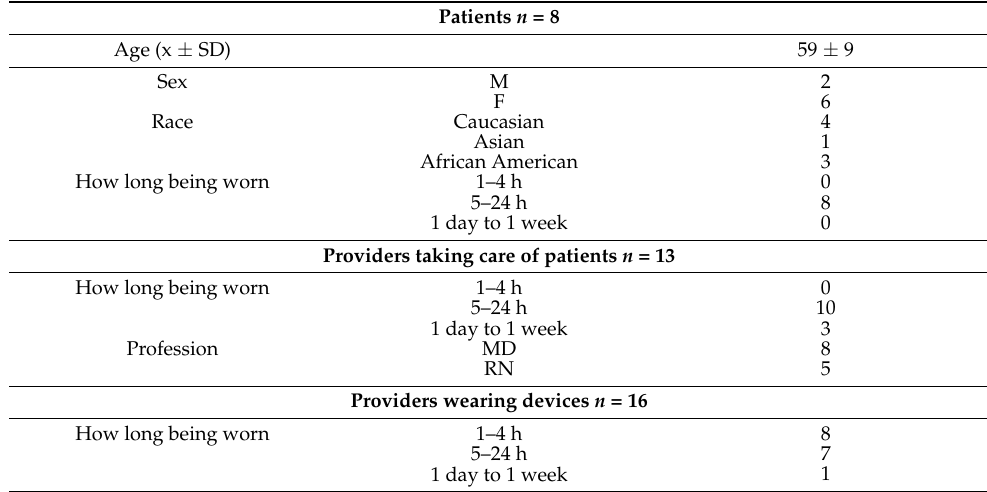
Table 1. Demographic characteristics of studied